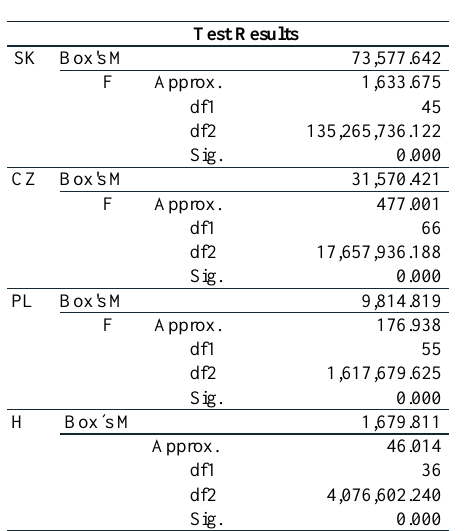
Table 3. Box´s test of equality of covariance